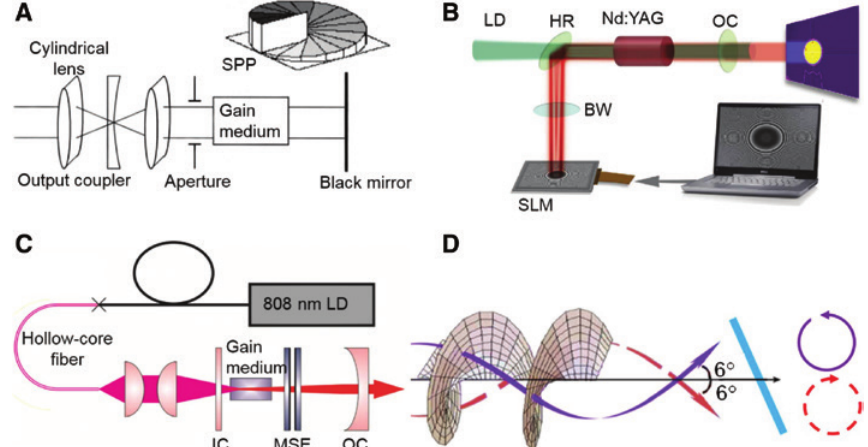
Figure 7: Vortex lasing from laser cavity. (A) The first OAM laser resonator configuration, with spiral phase element (SPE) as black mirror. Reprinted from Ref. [160]. (B) Schematic of the digital laser composed of Brewster window (BW), spatial light modulators (SLMs), high reflectivity (HR) mirror at an angle of 45 ° , Nd:YAG gain medium pumped by an external laser diode (LD) source and the output coupler (OC). Also shown is a superposition of two Laguerre-Gaussian modes of opposite but equal azimuthal index, l = ± 25. Reprinted from Ref. [161]. (C) Schematic of experimental laser setup for the handedness controlled Laguerre-Gaussian (LG01) mode, with a pair of mode-selection element (MSE), input coupler (IC), output coupler (OC) and Nd:YAG gain medium. Reprinted from Ref. [162]. (D) Schematic description of the concept of using Poynting vector skew angle to introduce energy loss discrimination based on the Poynting vector of Laguerre-Gaussian (LG) modes along the propagation direction. The tilted bar on the path is the etalon and the purple solid circle/red dash circle indicates the trajectory of the Poynting vector LG mode of different handedness. Reprinted from Ref.